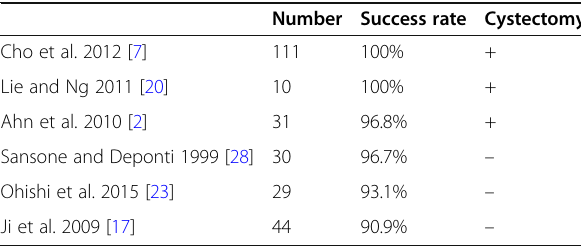
Table 1 Success rates of communication enlargement surgery with and without